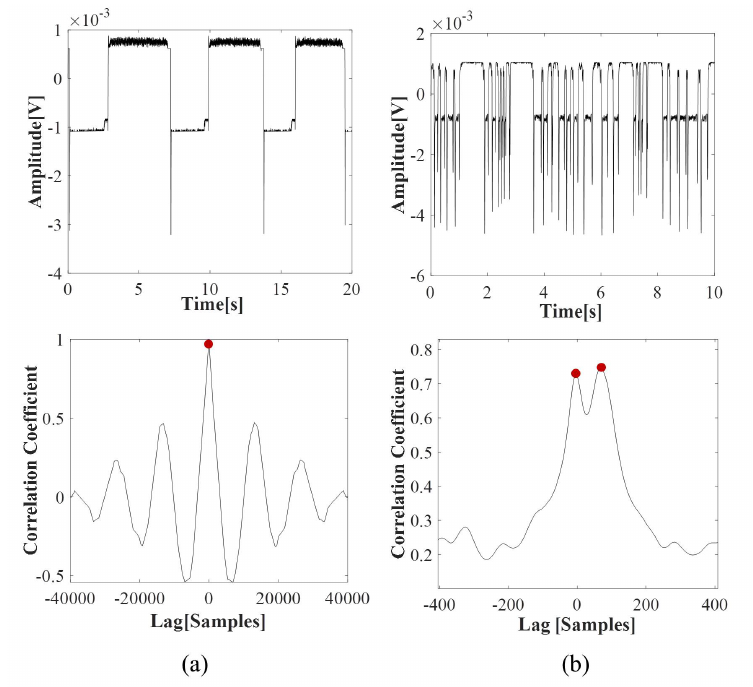
Figure 11. The trends of a signal { ph 2 } and the cross-correlation functions: ( a ) in the serpentine microchannel G-320 and ( b ) in the serpentine microchannel